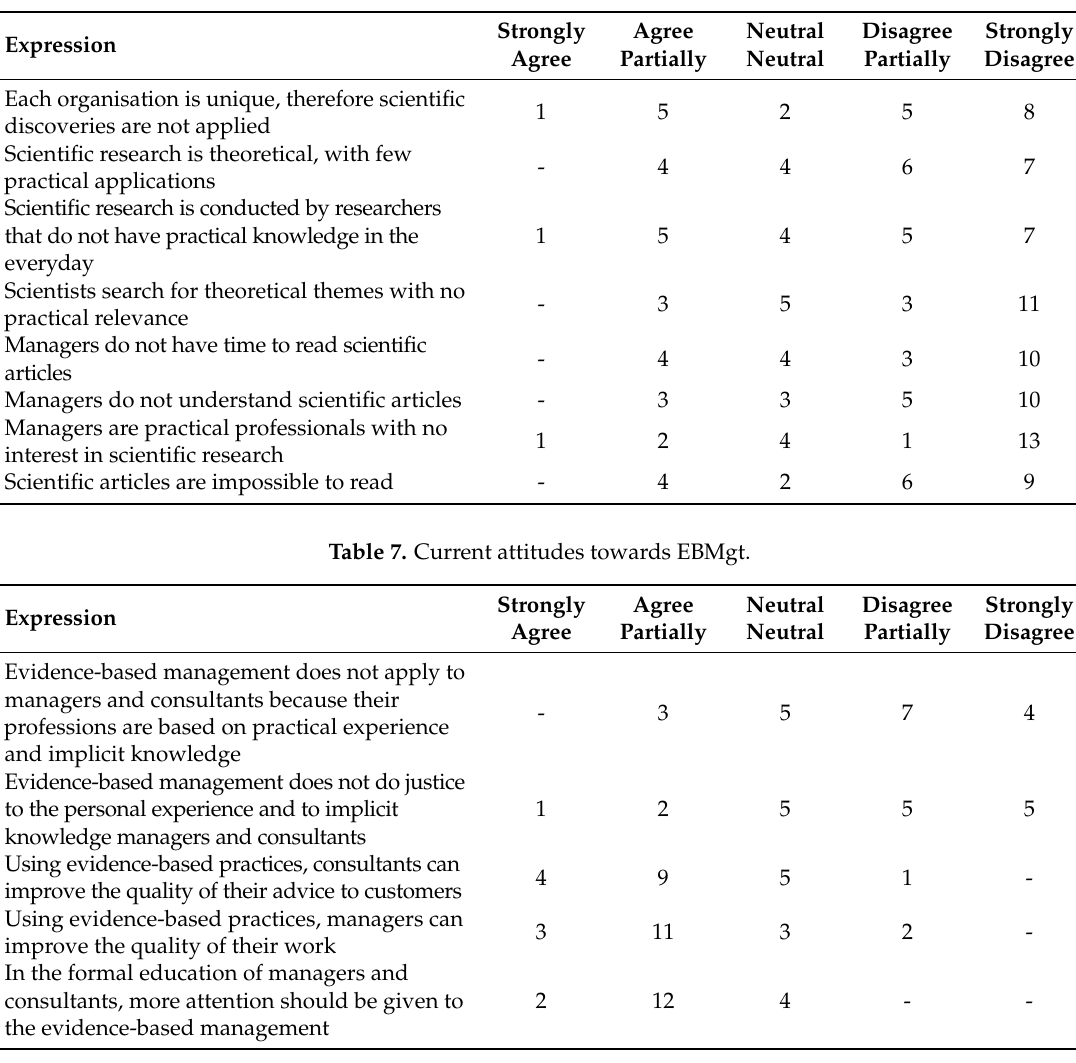
Table 6. Current attitudes towards scientific research.